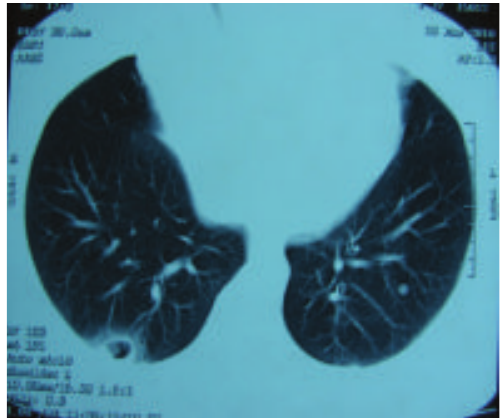
Figure 1: Computed chest tomography: thick-walled cavitary lesion of 15 × 26mm in size in posterobasal segment of the right lung lower lobe.